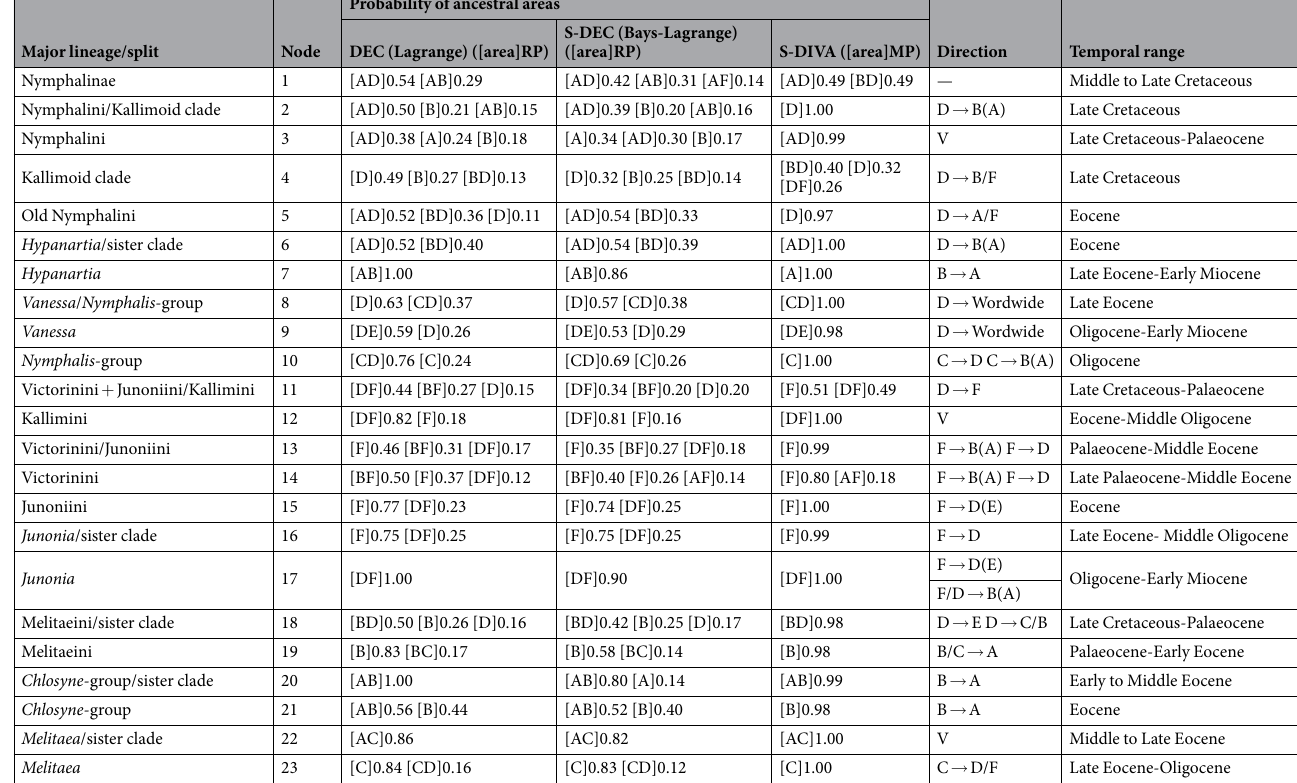
Table 2. Ancestral area reconstruction for major clades of Nymphalinae. Node labels correspond to Table 1 and Fig. 1. Direction reflects the path of the dispersal. Temporal range considers the age value of major lineages or splits under Calibration Plan 1 A, as shown in Table 1. Abbreviations: S-DIVA, Statistical Dispersal-Vicariance Analysis; DEC (Lagrange), Dispersal-Extinction-Cladogenesis Analysis; S-DEC (Bays-Lagrange), Statistical DEC Analysis; RP, relative probability; MP, marginal probability; V, vicariance. Biogeographical areas: A, Neotropical; B, Nearctic; C, Palaearctic; D, Oriental; E, Australasian; F, Afrotropical. The slash (/) between different realms means the diverged dispersal route for one clade; the realm in the parentheses means the destination for some groups in the same route of